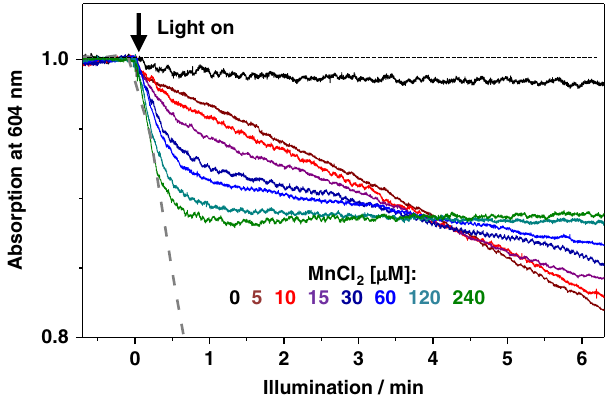
Fig. 4 Kinetics of light-dependent electron fl ow in Mn-depleted PSII at various concentrations of solvated Mn 2 + ions. The decrease in absorption at 604 nm monitors the light-driven reduction of the arti fi cial electron acceptor (60 µ M DCPIP ox , pH 7) due to the oxidation of Mn 2 + ions by PSII. See Supplementary Fig. 7 for traces on a longer time scale. The gray dashed line illustrates the rate of DCPIP reduction by fully intact PSII under similar conditions (Supplementary Fig. 5). Source data are provided as a Source Data fi